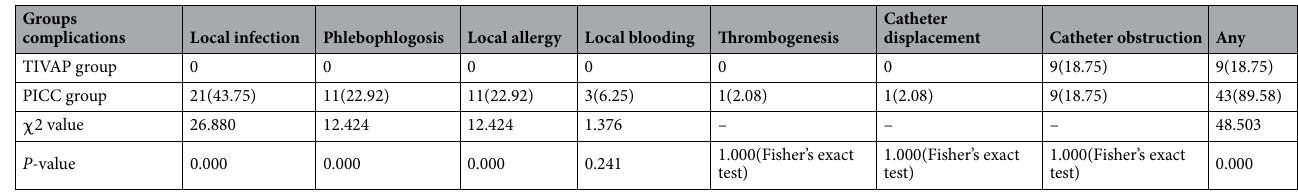
Table 2. Comparison of complications [n